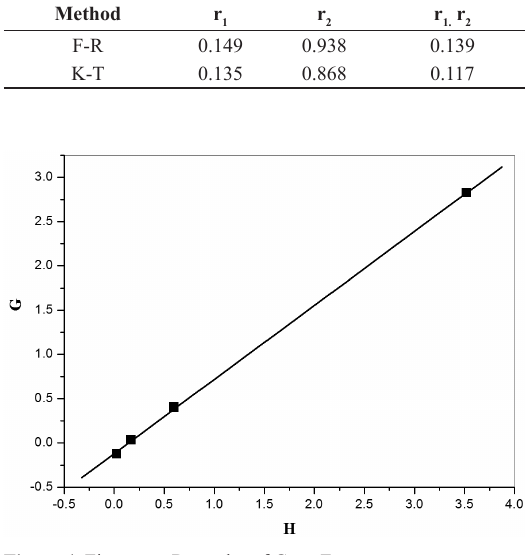
Figure 4. Finneman-Ross plot of G vs. F.